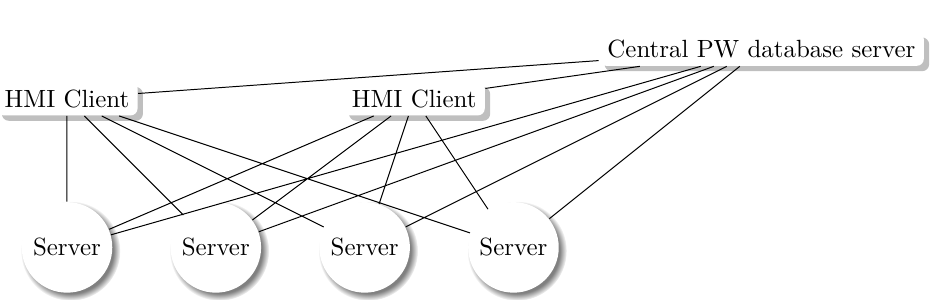
Figure 2: IIoT setting with central password distribution